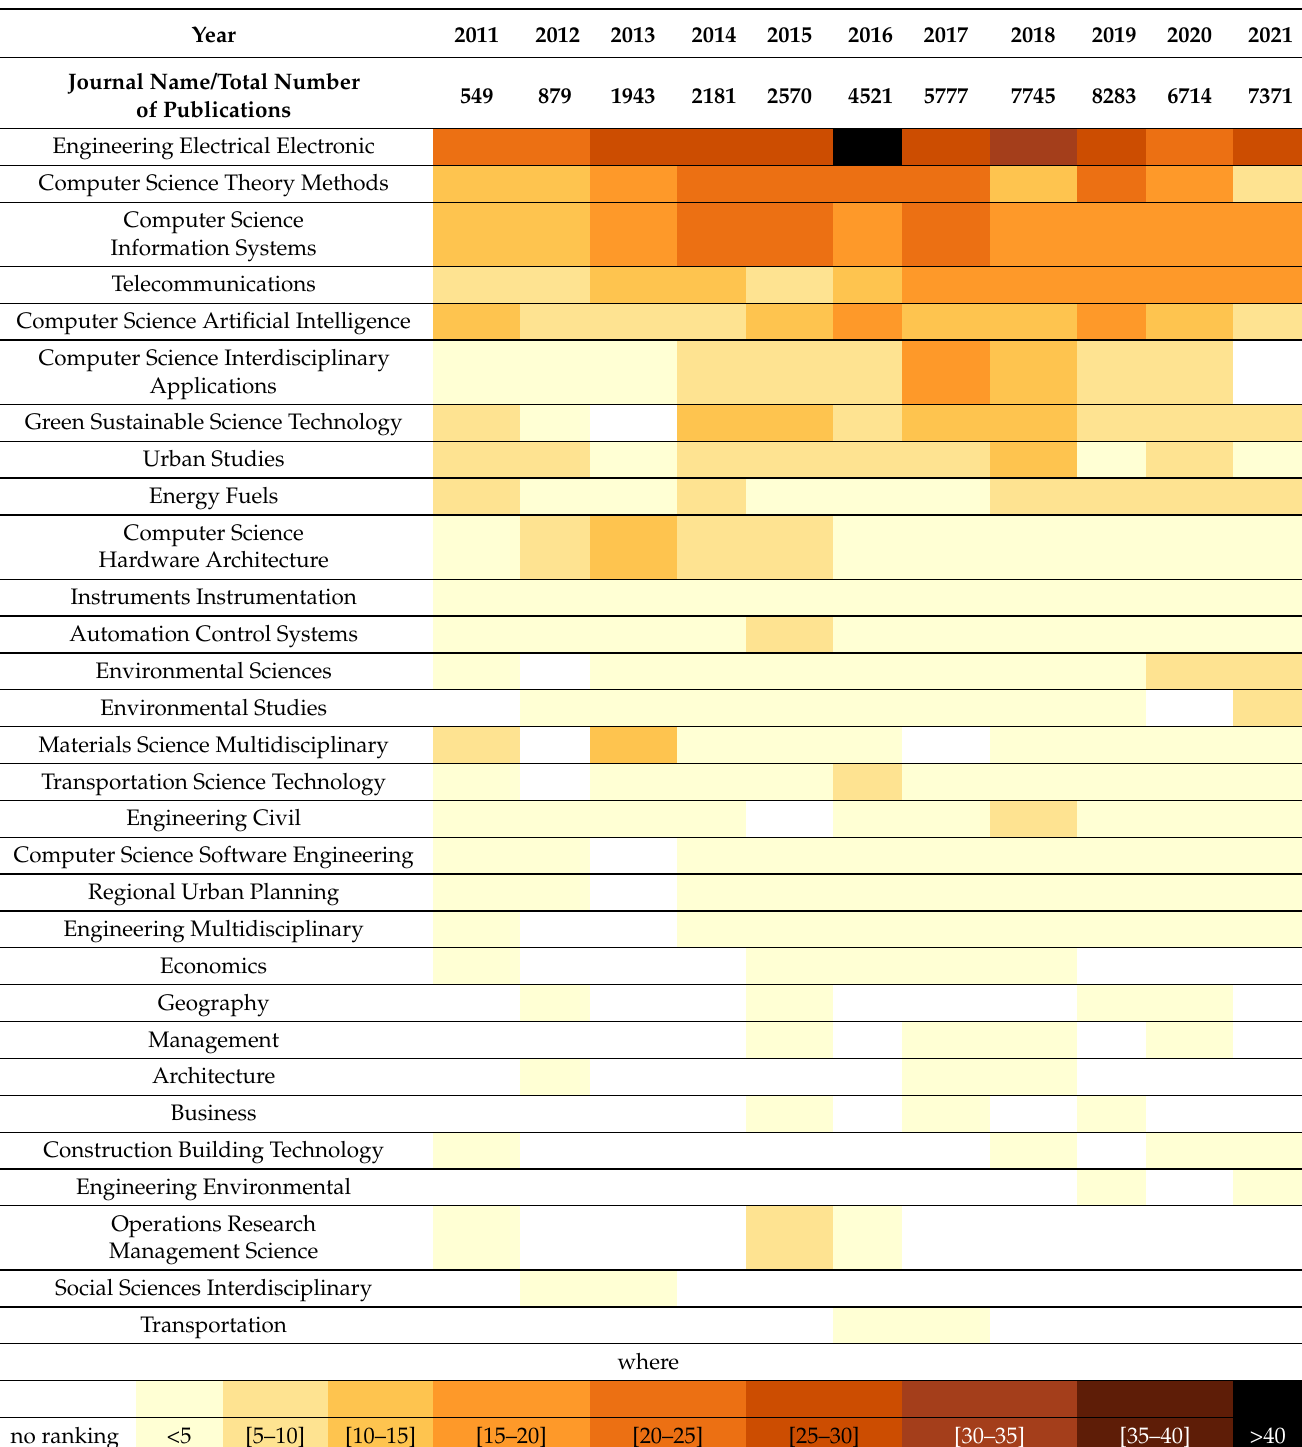
Table 2. Ranking of journals from the Web of Science database in the years 2011–2021 according to the key for the occurrence of the smart city